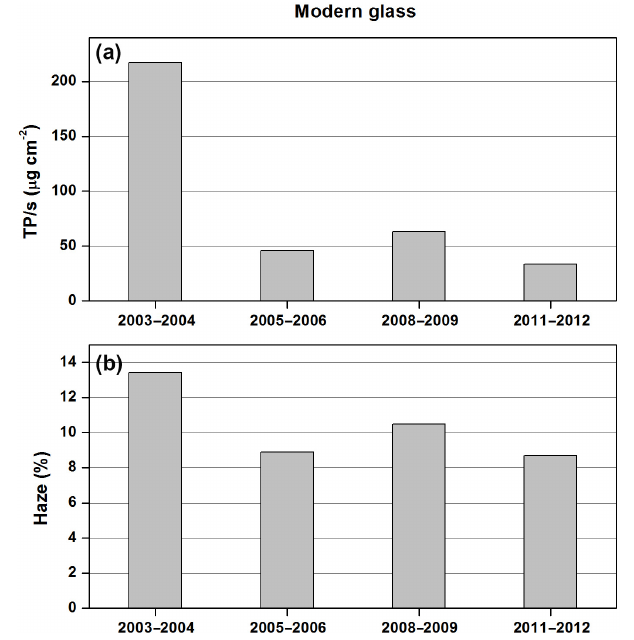
Figure 6. (a) TPs − 1 (µgcm − 2 ) and (b) haze (%) for modern glass